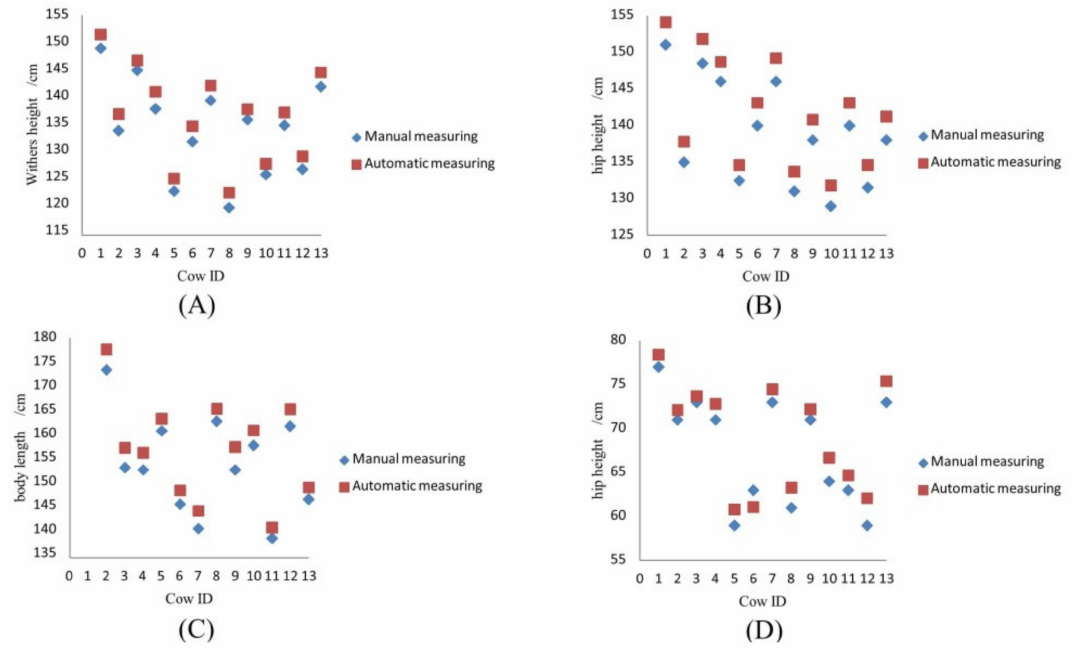
Figure 15. Comparison of manual measurement and the proposed method for the four different cattle body parameters: ( A ) Withers height, ( B ) hip height, ( C ) body length and ( D ) chest depth.